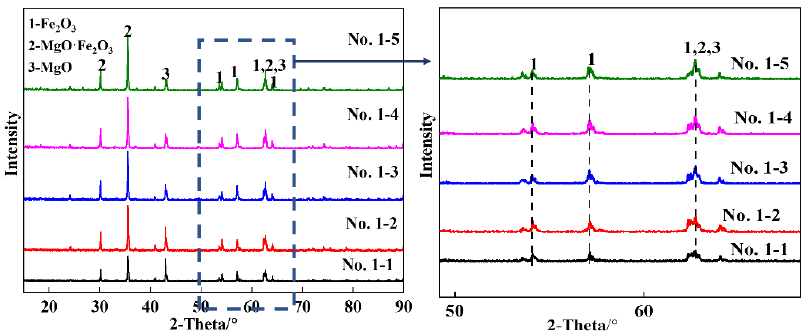
Figure 8. The XRD analysis of Fe 2 O 3